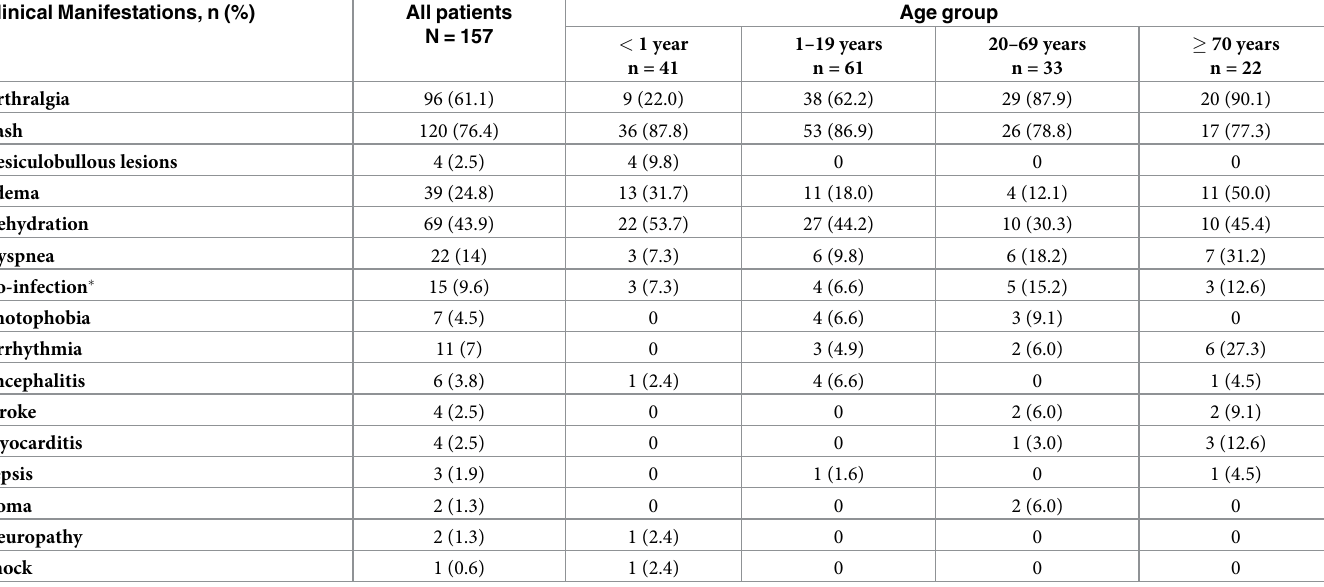
Table 5. Clinical characteristics of hospitalized chikungunya virus-infected patients enrolled in the Sentinel Enhanced Dengue Surveillance System, May–Decem- ber, 2014. Clinical Manifestations, n (%) All patients N =